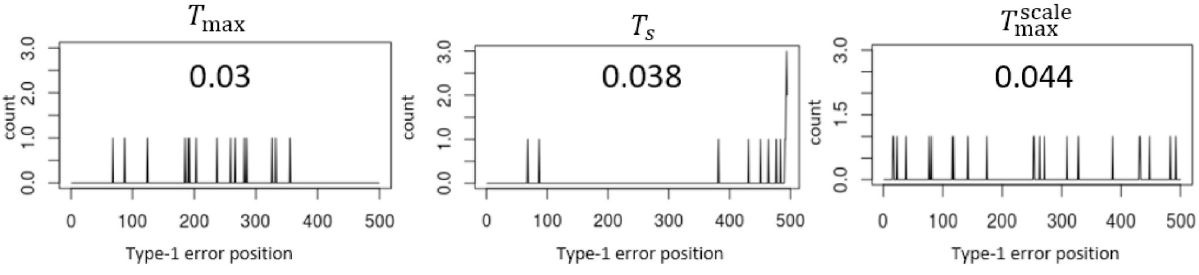
Fig 9. Time positions of type-1 error in Lorenz